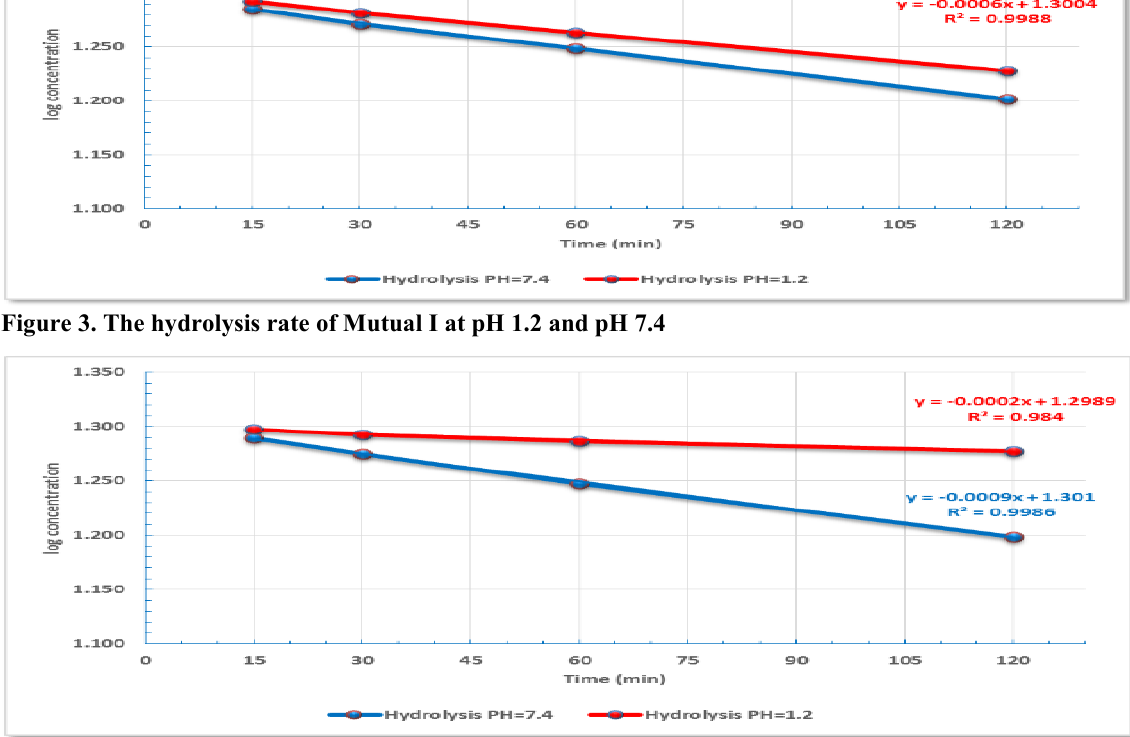
Figure 4.The hydrolysis rate of Mutual ІІ at pH 1.2 and pH 7.4